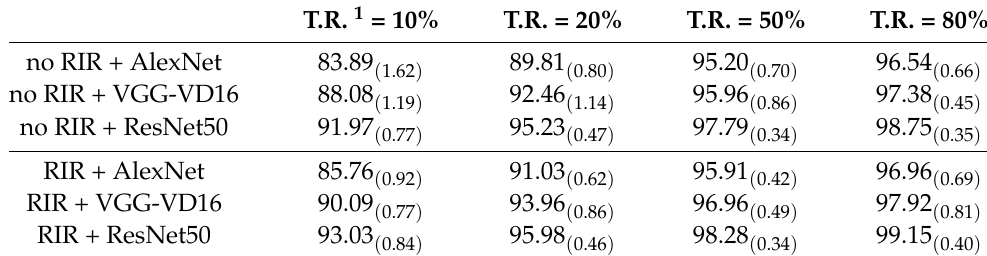
Figure 7. Evaluation of the temperature T and tuning parameter λ as hyper-parameters for the AlexNet-based RIR-net on the UC dataset. The testing classification results are measuring in terms of overall accuracy (%). The testing accuracy of the model only with cross-entropy criteria is 84.01% and 89.81% for the training ratios of 10% and 20%, respectively. ( a ) training ratio = 10%; ( b ) training ratio = 20%. Table 2. Classification accuracies (%) on the UC data